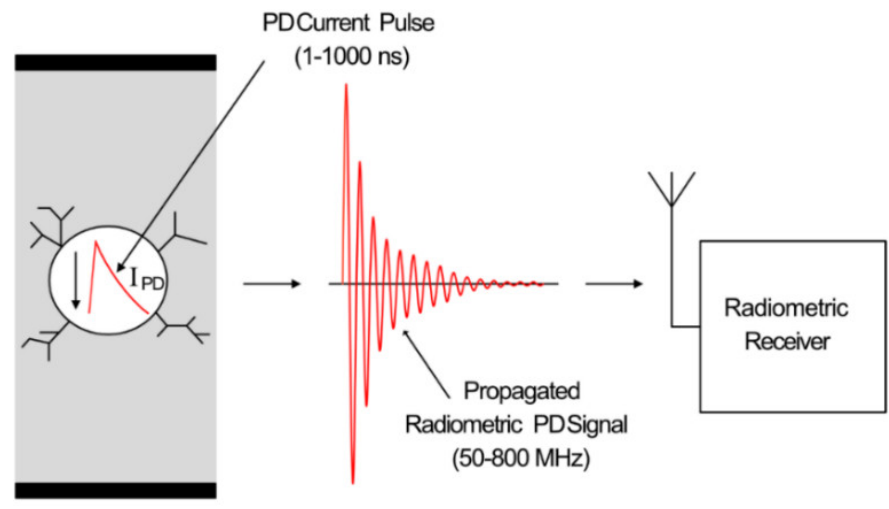
Figure 3. Radiometric PD propagation and reception using a radio receiver.